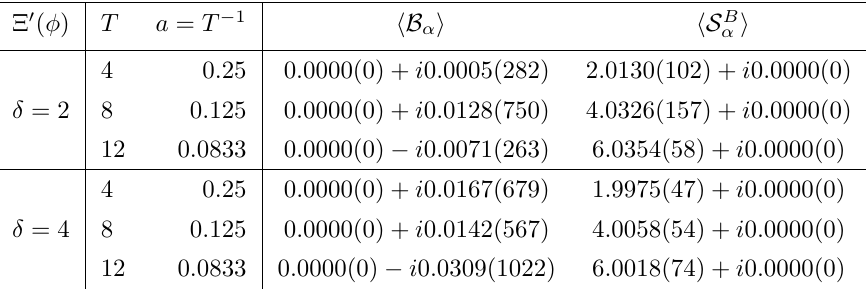
Table 4 . Expectation values of the auxiliary field B α and the bosonic action S B symmetric models with δ = 2 , 4 .